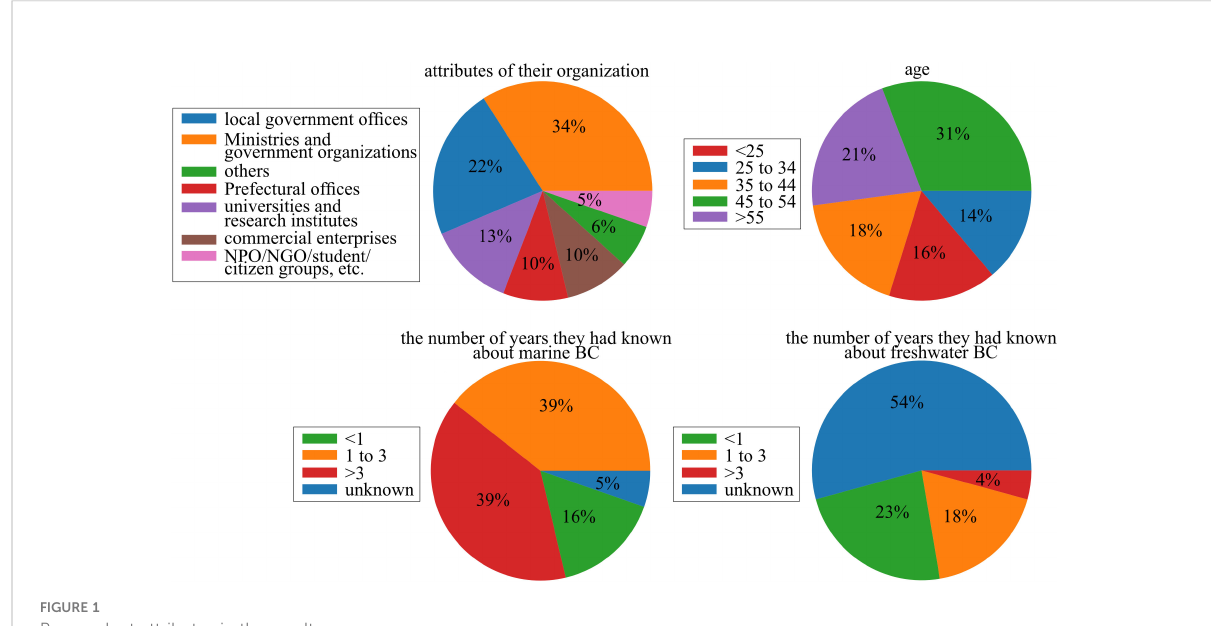
FIGURE 1 Respondent attributes in the results.